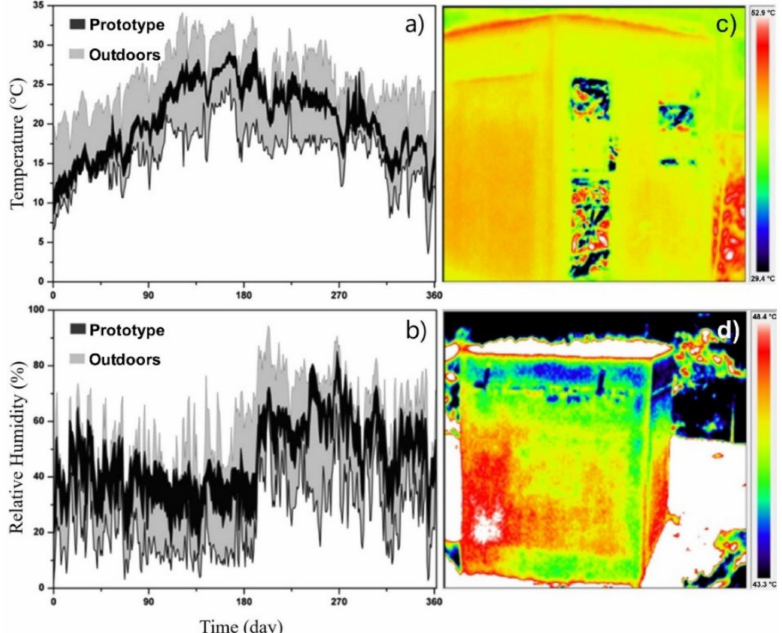
Figure 2. ( a ) Temperature and ( b ) relative humidity of the waste PET bottles prototype and outdoor environment. Thermographic images of the PET prototype showing ( c ) the right side and façade of the room and ( d ) the backside of the